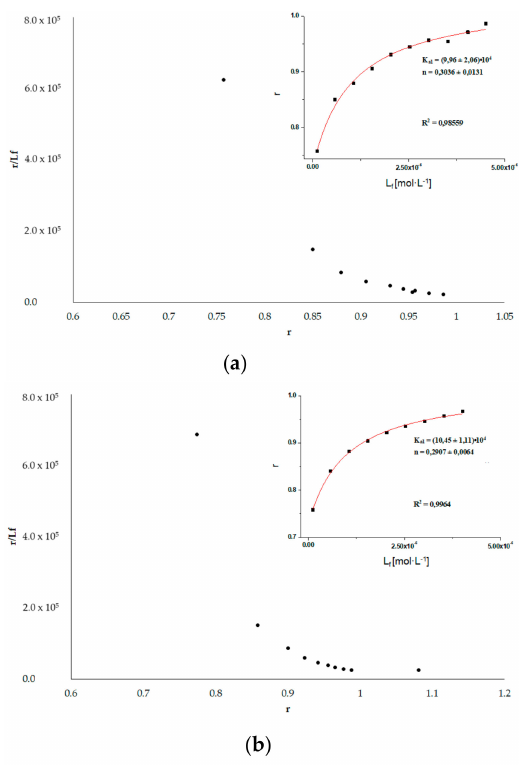
Figure 9. Scatchard curve for ( a ) Phb–HSA FR and ( b ) Phb–HSA INC systems. Inserts show the binding isotherms; λ ex 295 nm.